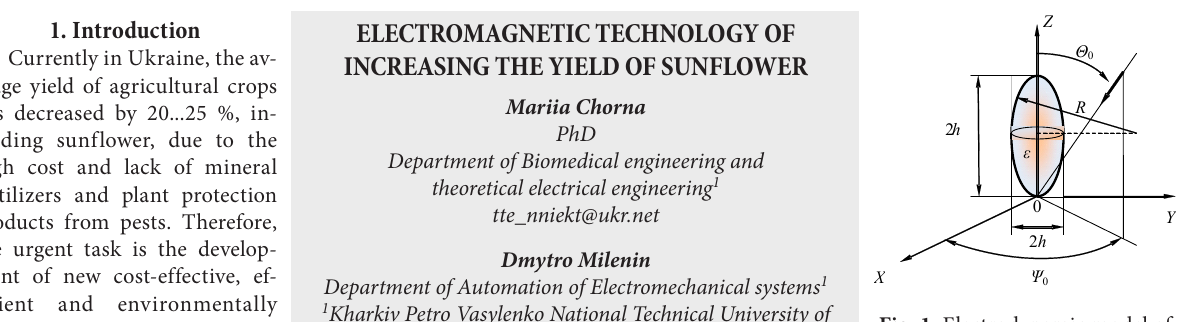
Fig. 1. Electrodynamic model of sunflower seed Calculations of E av /E 0